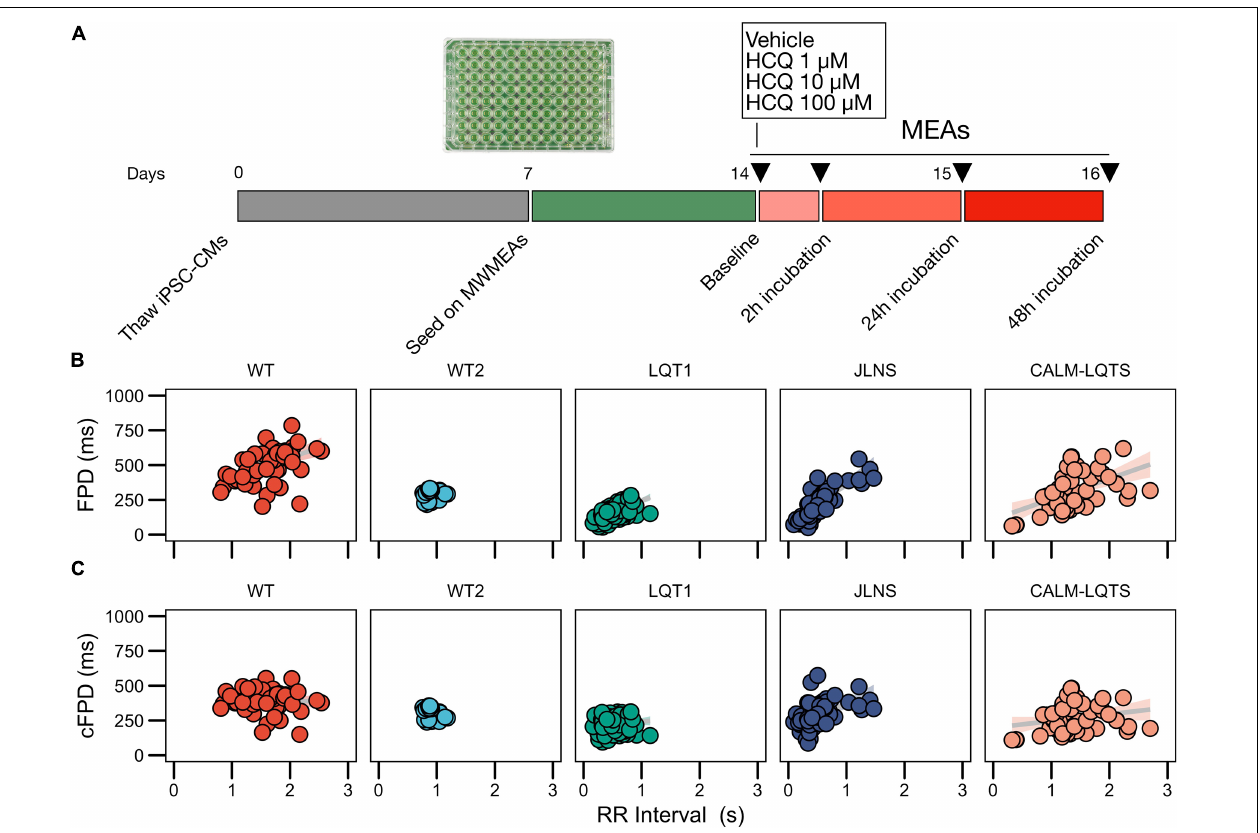
FIGURE 1 | (A) Study protocol. (B) Relationships between FPD and RR for the iPSC lines used in this study measured with MWMEA at Baseline. Data were fitted with a linear model. N of MEA at Baseline: WT: 58; WT2: 48; LQT1: 106; JLNS: 62; CALM-LQTS: 56. (C) Relationships between cFPD and RR for the iPSC lines used in this study measured with MWMEA at Baseline. Data were fitted with a linear model. N of MEA at Baseline: WT: 58; WT2: 48; LQT1: 106; JLNS: 62; CALM-LQTS: